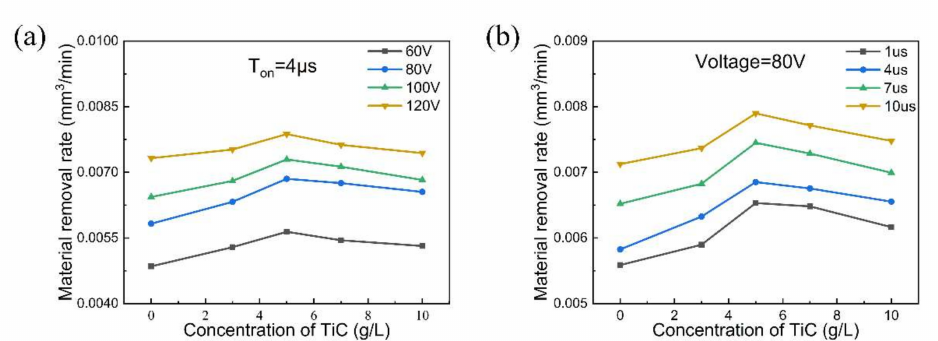
Figure 6. Material removal rates (MRRs) obtained with ( a ) di ff erent voltages and ( b ) di ff erent pulse durations in the TiC dielectric with concentrations of 0, 3, 5, 7, and 10 g / L.